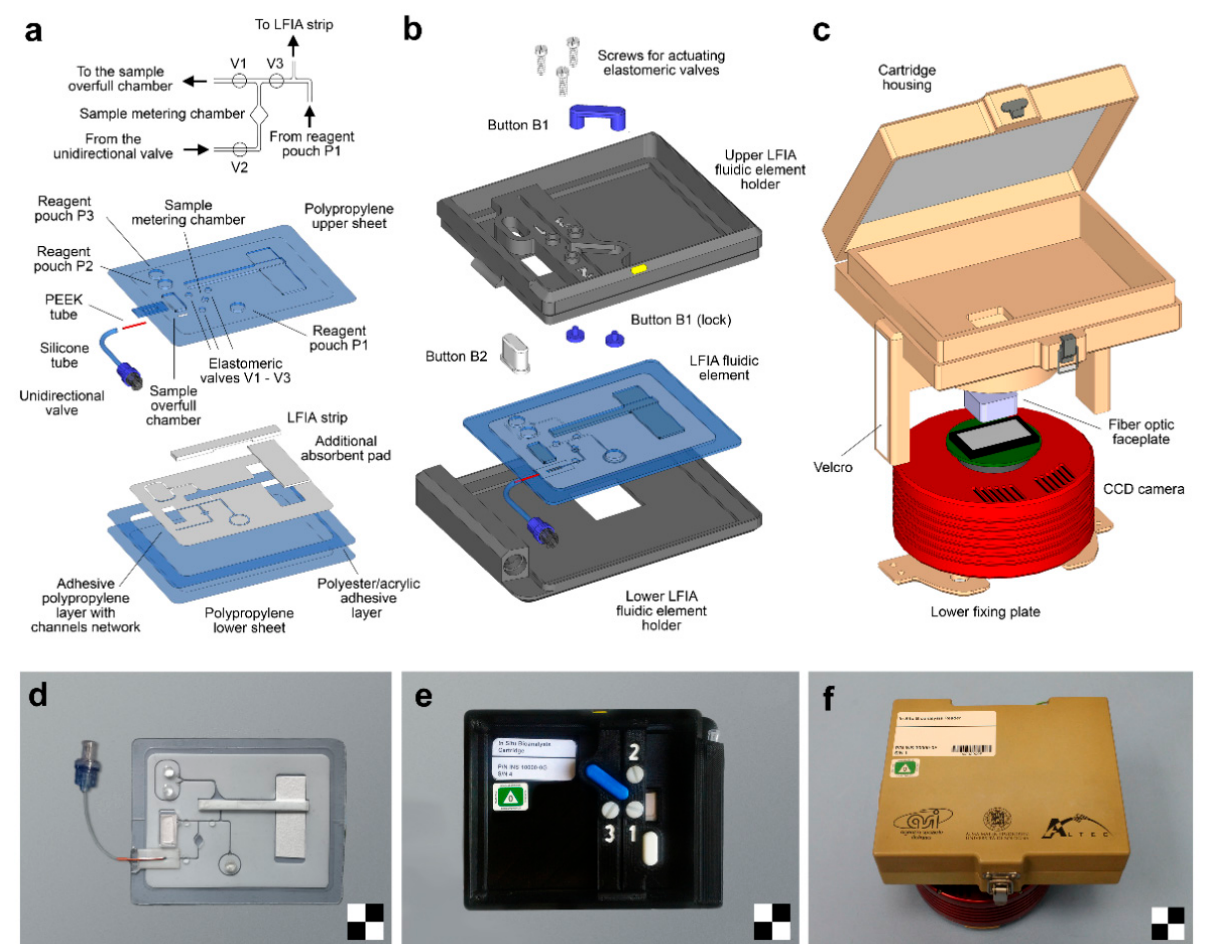
Figure 3. Portable CL-LFIA biosensor for the measurement of salivary cortisol levels used aboard the International Space Station (ISS): schematic drawings and images of ( a , d ) the LFIA fluidic element, ( b , e ) the LFIA cartridge and ( c , f ) the CL reader. A detailed view of the fluidics of the LFIA fluidic element around the sample metering chamber is shown on top of panel ( a ). Scale checkerboards are 2 × 2 cm. Reprinted from Ref. [69], Copyright (2018), with permission from Elsevier.